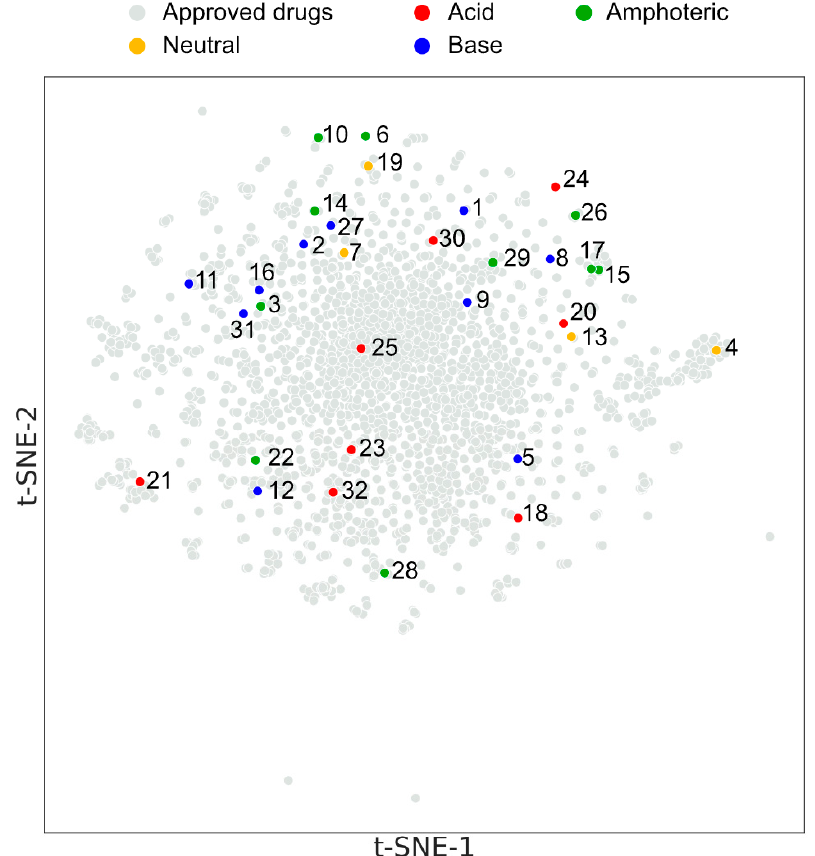
Figure 3. t-SNE plot of the APIs used in the experiment. The database of the ‘approved drugs’ contained 2560 molecules. The compounds are numbered as in Figure 2D. t-SNE—t-distributed stochastic neighbor embedding.